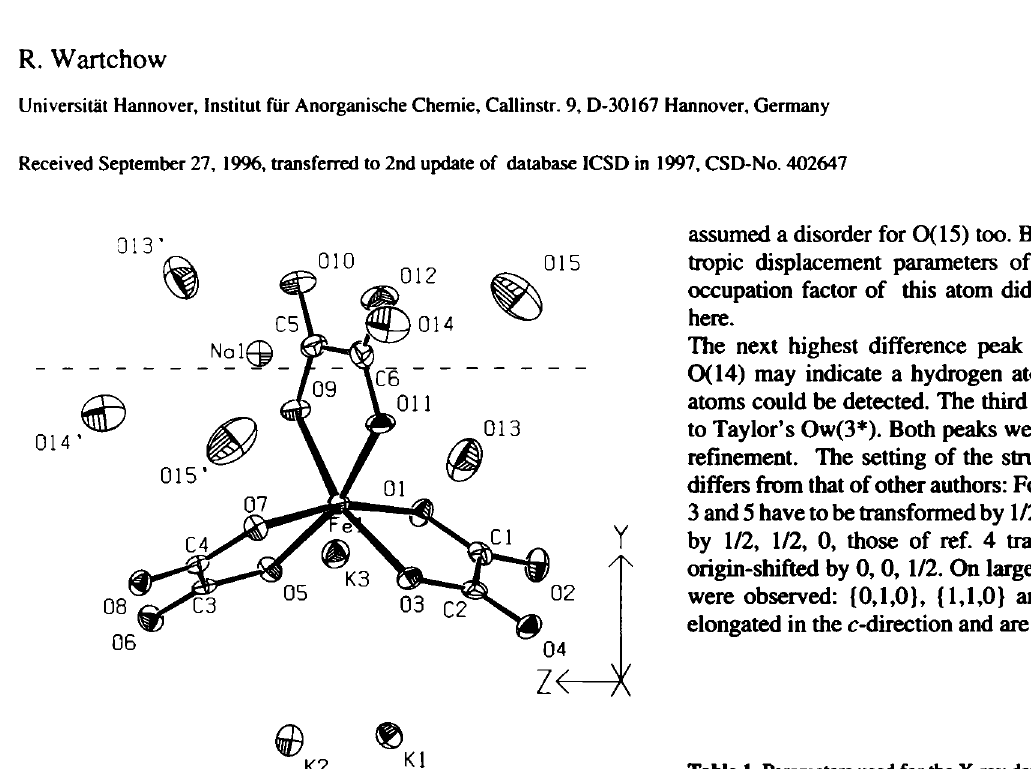
Table 1. Parameters used for the X-ray data collection Crystal: